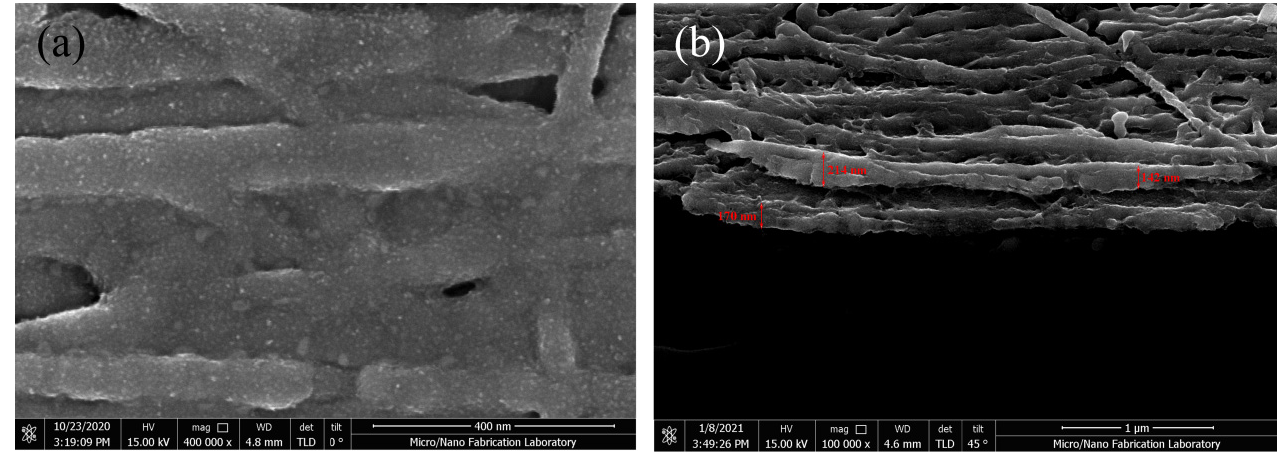
Figure 5. The SEM photos of the CNT-Cu composite cross-section viewed at 90° and ( a ) at 45° ( b ). At the same time, compared with pure CNT, its adhesion on the substrate is stable, and it is not easy to cause the wire to fall off due to the thermal expansion coefficient mismatch at high temperatures. The comparison result is shown in Figure 6a,b.